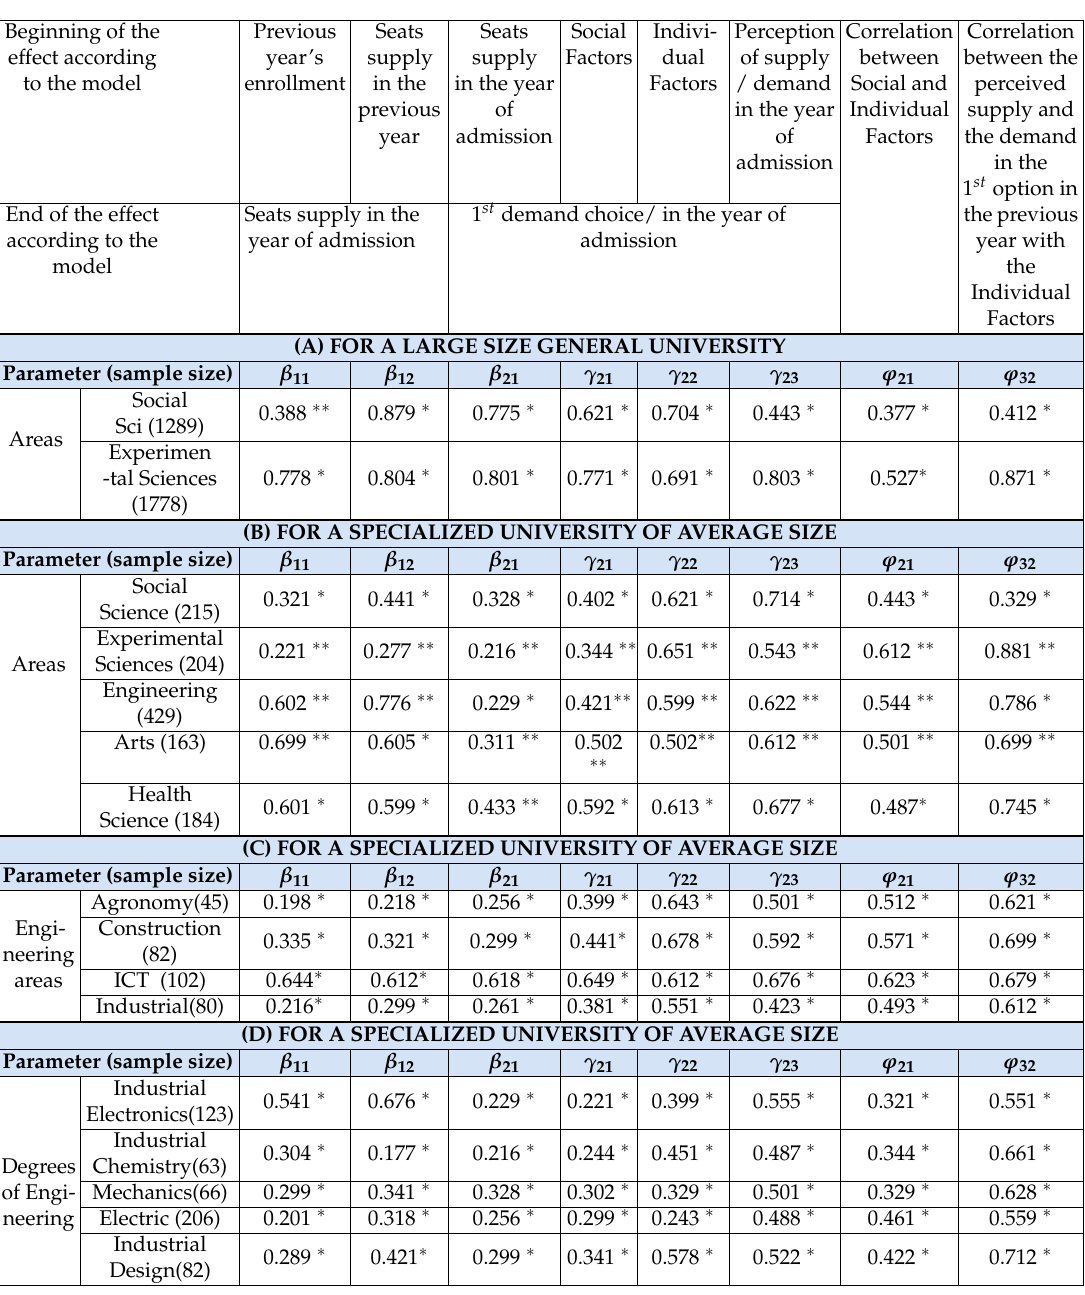
Table 4. Estimation (and statistical significance) of each standardized structural parameter. ( A ) and ( B ) by area, ( C ) by engineering area, and ( D ) by industrial engineering